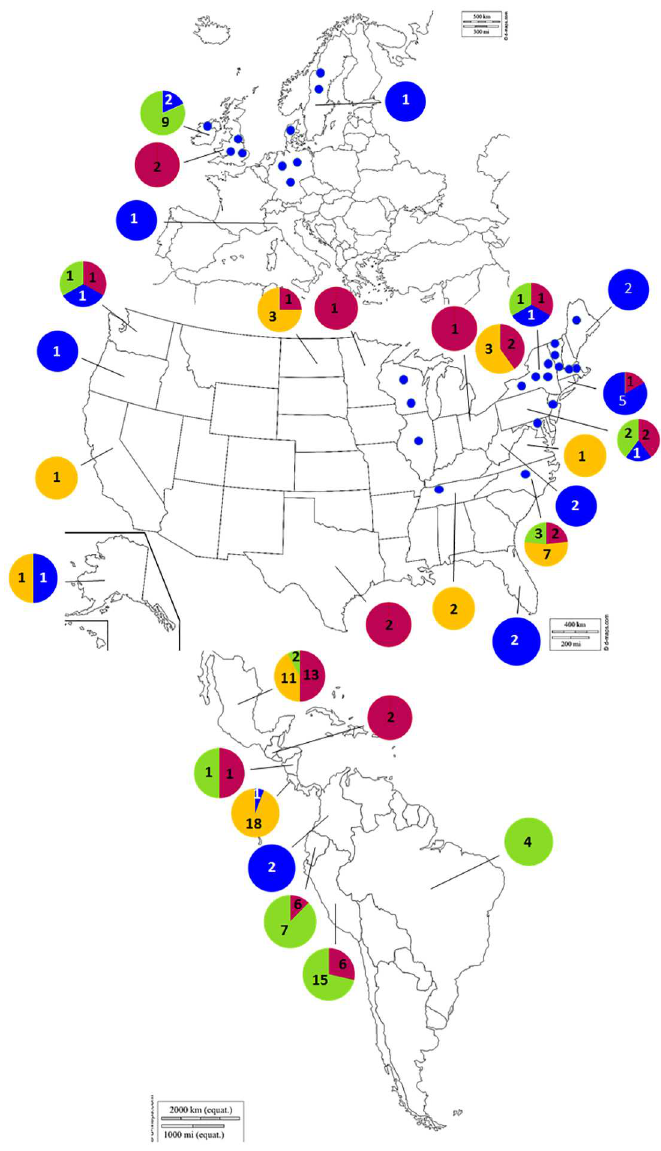
Fig 1. Geographic distribution of multilocus SSR genotypes of Phytophthora infestans . Small blue circles indicateFAM-1 SSR lineage found before 1900, and larger circles indicate samplescollected after 1900. Samples were assignedto genetic clusters basedon the highestQ value and correspond to K = 4 groupsby color as in Fig 2. The FAM-1 lineagewas geographically widespread. Samples are locatedby state in the US and by country in the rest of the world. Maps reprintedfrom www.d-maps.com under a CC BY license, with permissionfrom DanielDalet,